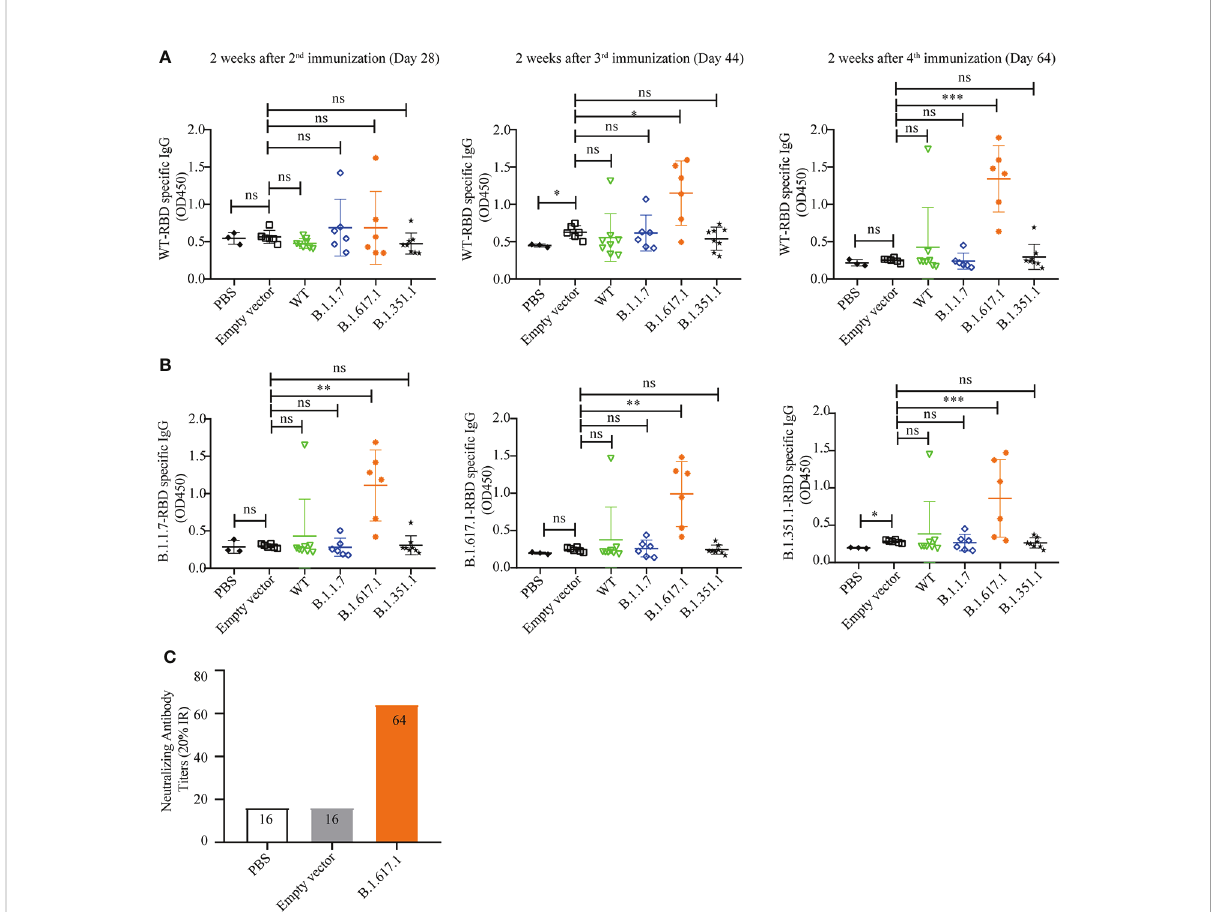
FIGURE 4 Humoral immune responses elicited by wild-type SARS-CoV-2 Spike RBD and its mutant variants. (A) Wild-type RBD-speci fi c IgG serum antibody after 2nd (day 28), 3rd (day 44), and 4th (day 64) immunizations. (B) B.1.1.7, B.1.671.1, and B.1.1351 mRBD-speci fi c IgG serum antibody after 4th (day 64) immunization. (C) The neutralization titer of B.1.617.1 mRBD antiserum against wild-type RBD was determined by competitive ELISA. Serum samples were collected 2 weeks after the fourth immunization (Day 64), and detected after mixing the samples from the same group in equal volume. Data points represent individual animals. For statistical analysis, t -test was performed to compare to PYD1/EBY200 (Empty vector) and PBS groups. Asterisks represent signi fi cance: * p < 0.05; ** p < 0.01; n = 6. ns, no signi fi cant; ***: p<